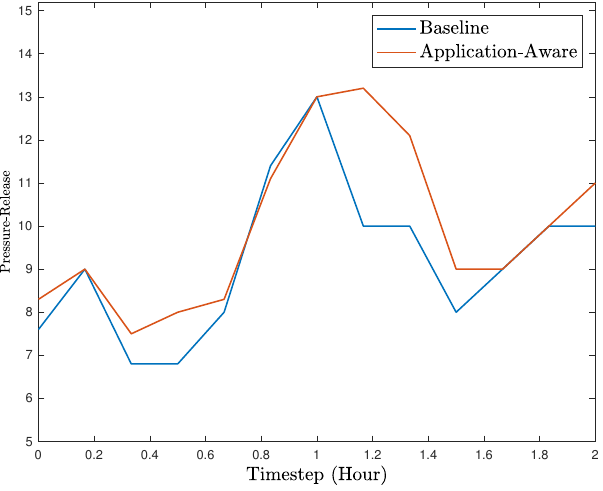
Figure 7. Utility (i.e., pressure-release) during a 2-h